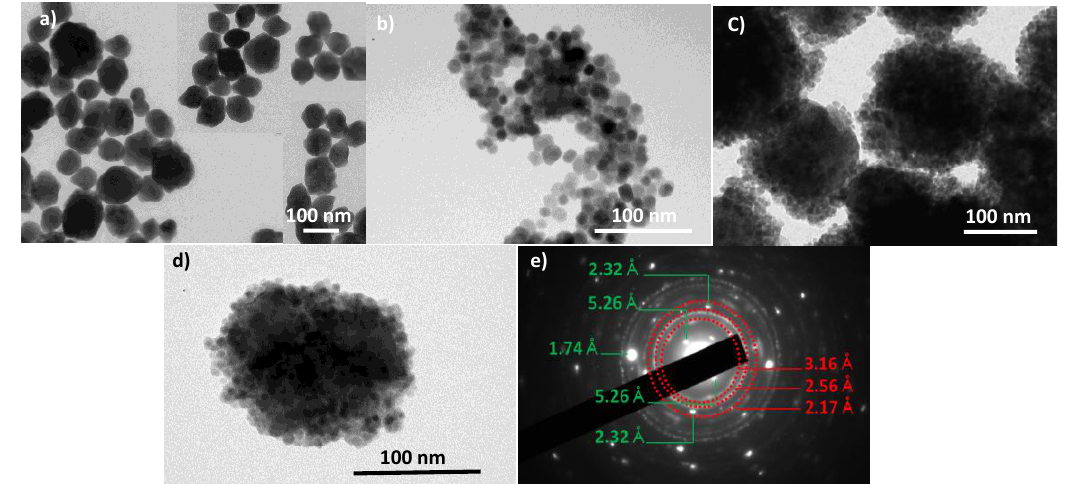
Figure 3. TEM images of ( a ) β-NaY 0.8 Eu 0.2 F 4 , ( b ) γ-Fe 2 O 3 and ( c ) β-NaY 0.8 Eu 0.2 F 4 @γ-Fe 2 O 3 NPs. ( d ) Micrograph of one representative composite particle and ( e ) its selected electron diffraction pattern (SAED). Note that the pattern can be fully indexed within the β-NaYF 4 hexagonal structure (light spots and related distances in green) and the γ -Fe 2 O 3 cubic one (dashed lines and related distances in red).